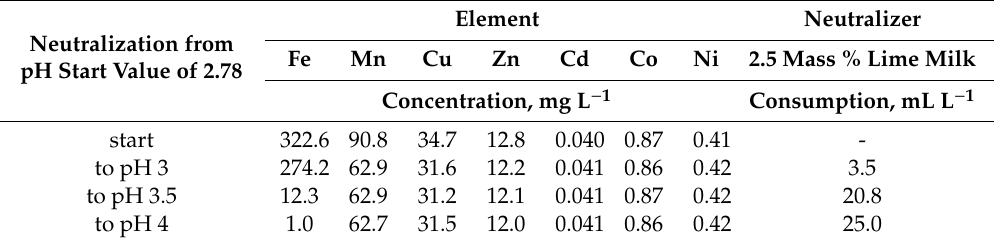
Table 3. Concentration of some elements in AMD after the first neutralization